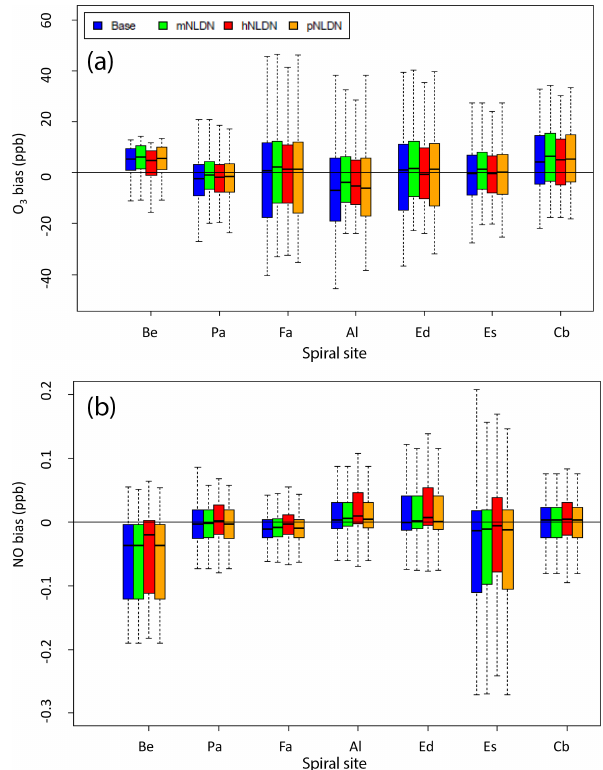
Figure 11. Bias (model – observation) distributions of O 3 (a) and NO (b) at each P-3B spiral site on 21, 22, 28, and 29 July 2011. Be: Beltsville, Pa: Padonia, Fa: Fair Hill, Al: Aldino, Ed: Edgewood, Es: Essex, and Cb: Chesapeake